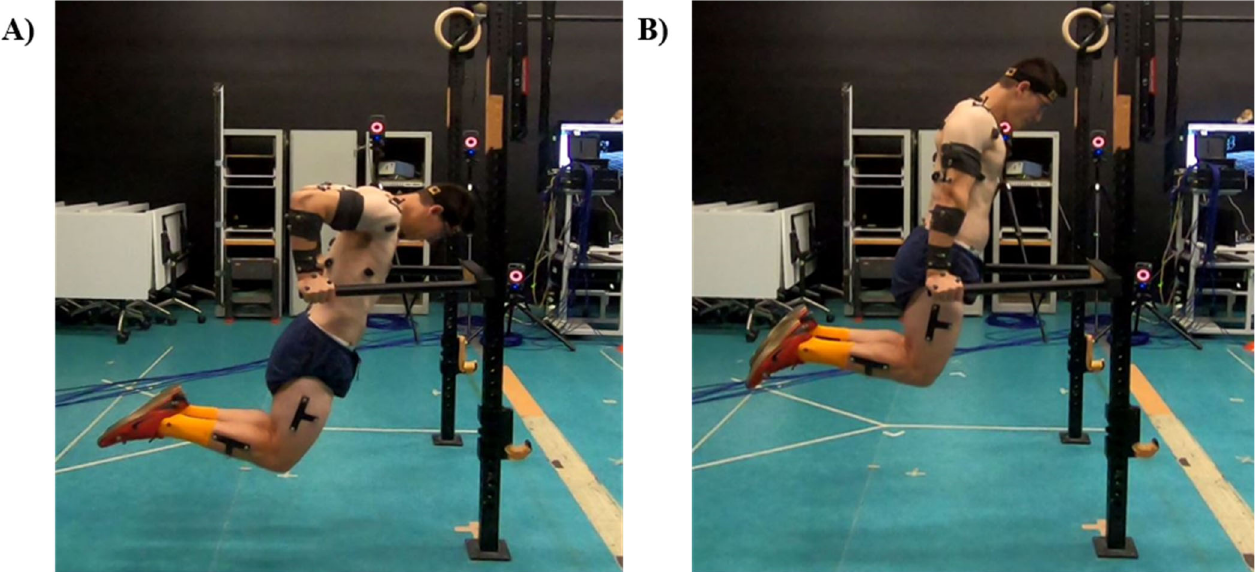
Figure 1. A typical bar dip with, ( A ) being the bottom position, and ( B ) being the start/ending posi ‐ tion.